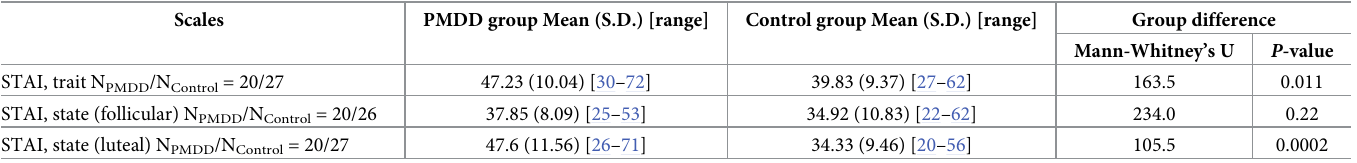
Table 2. State-Trait Anxiety Inventory (STAI) results in PMDD and control groups.